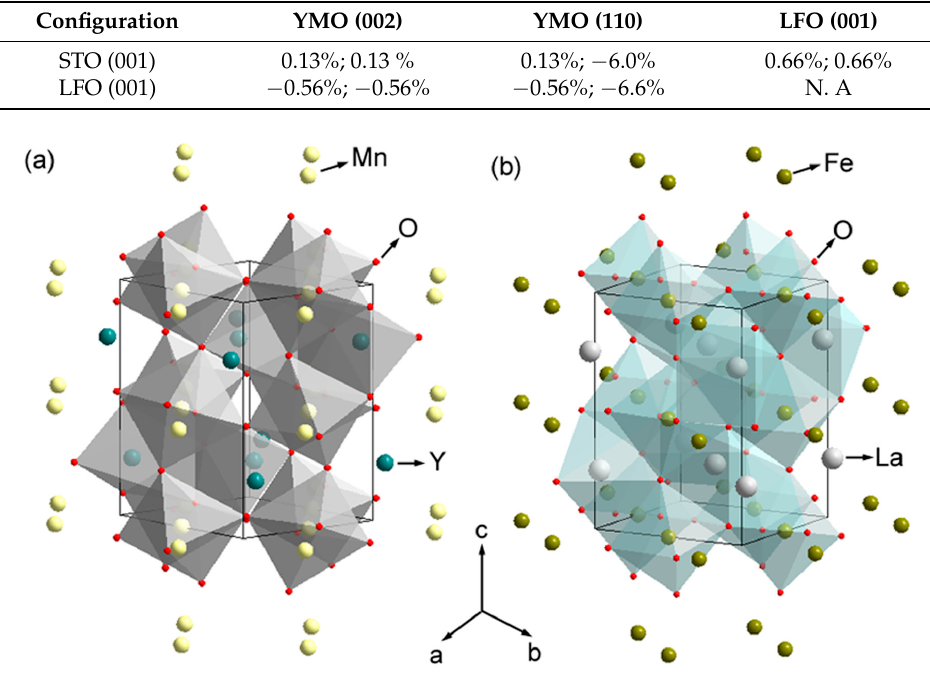
Table 2. Theoretical lattice mismatch ε , between component compounds, along two orthogonal in-plane directions when the substrate is (001)-STO. N. A represents not applied.